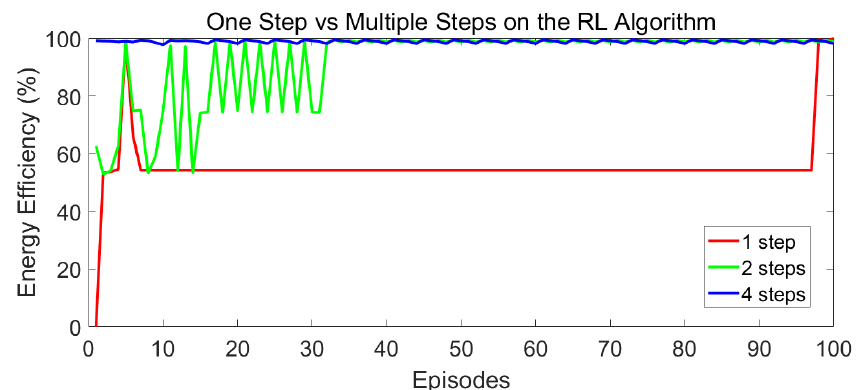
Figure 3. Comparison results for one-step and multistep reinforcement learning (RL) curves.